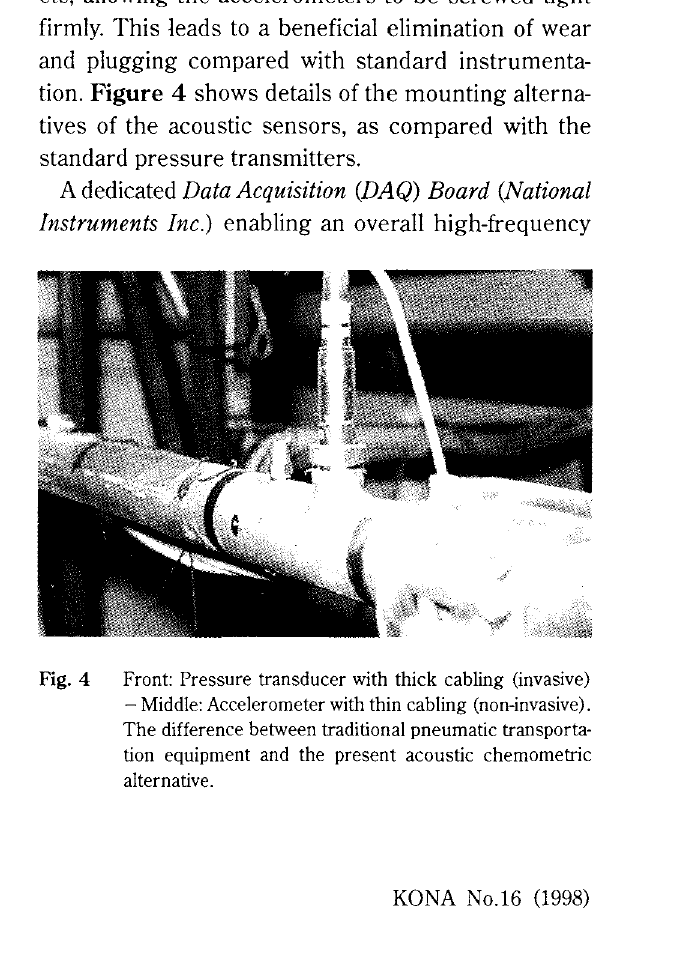
Front: Pressure transducer with thick cabling (invasive) -Middle: Accelerometer with thin cabling (non-invasive). The difference between traditional pneumatic transporta· tion equipment and the present acoustic chemometric